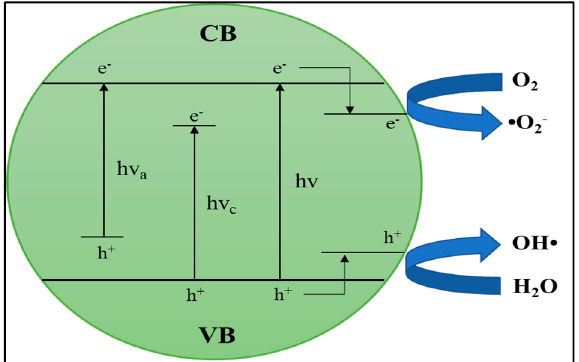
Figure 15. Simplified pure and doped TiO 2 photocatalyst mechanism: doping reduces bandgap, facilitating photoexcitation and reactive radical production. hv: pure TiO 2 ; hv c : cation-doped TiO 2 ; hv a : anion-doped TiO 2